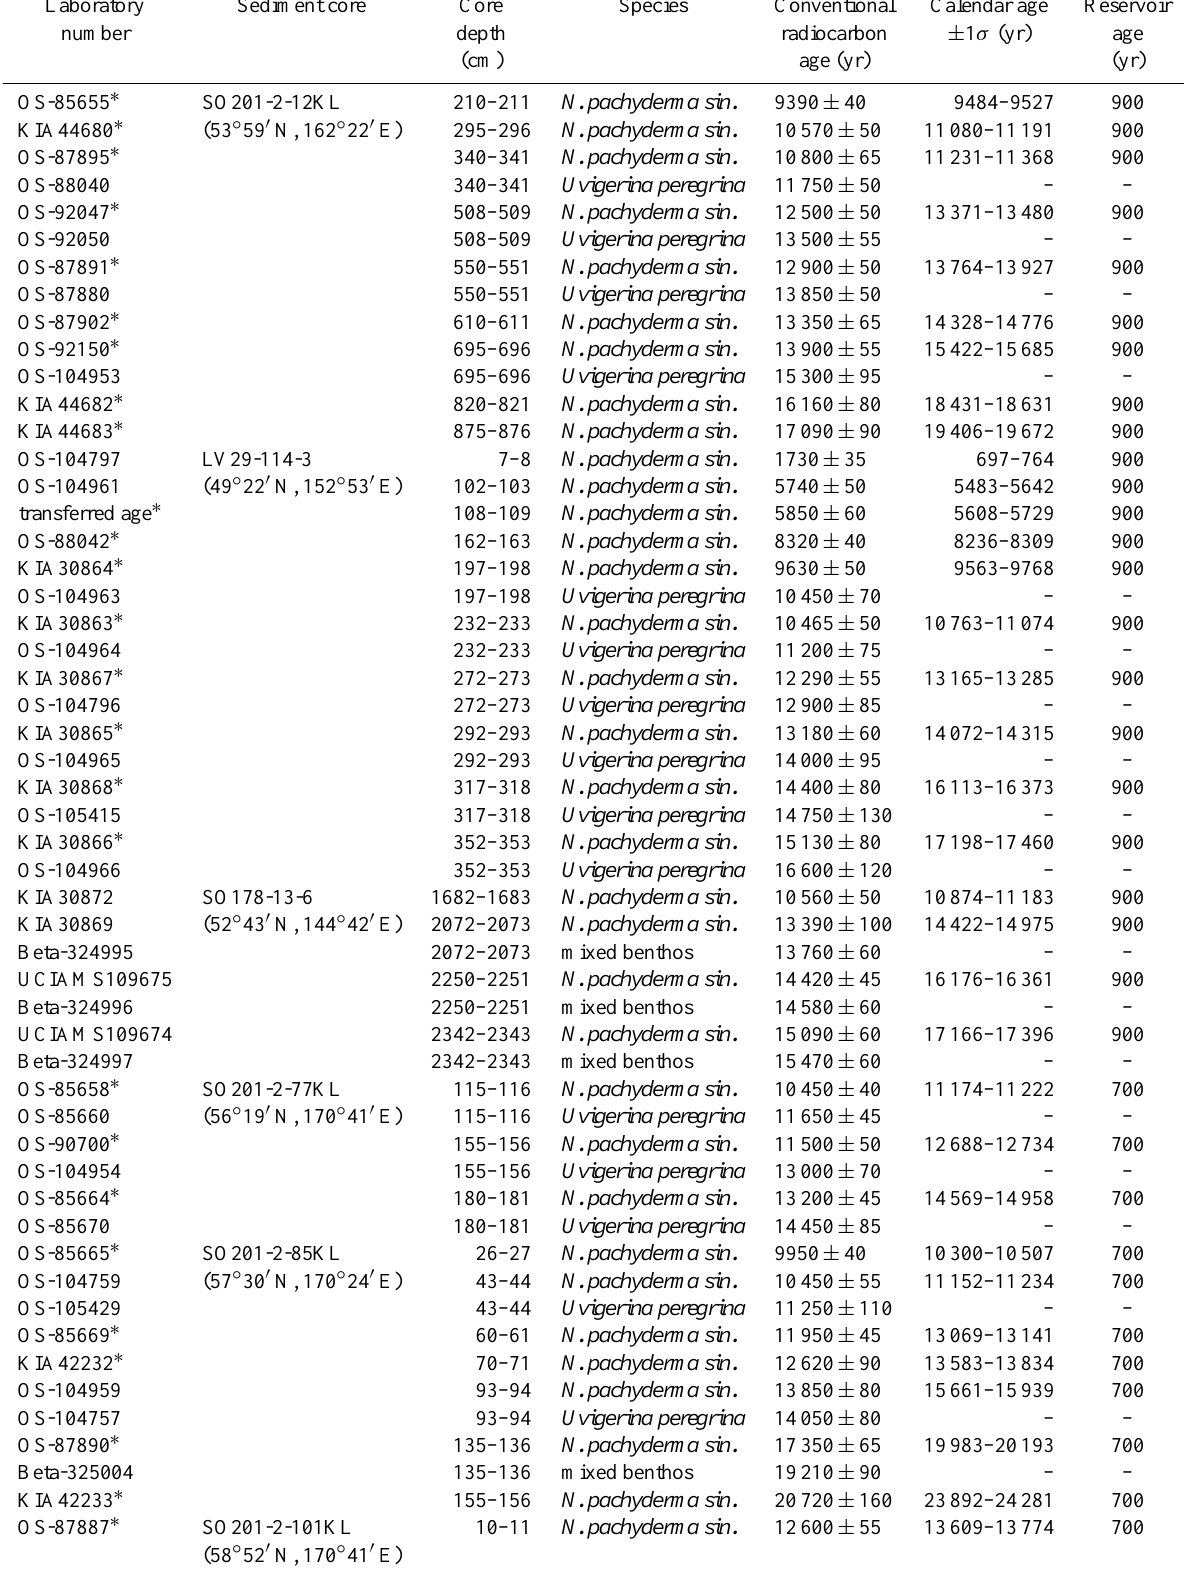
Table 2. AMS 14 C ages of the sediment records with calibrated calendar ages ± 1 σ (yr) and applied reservoir age correction used in this